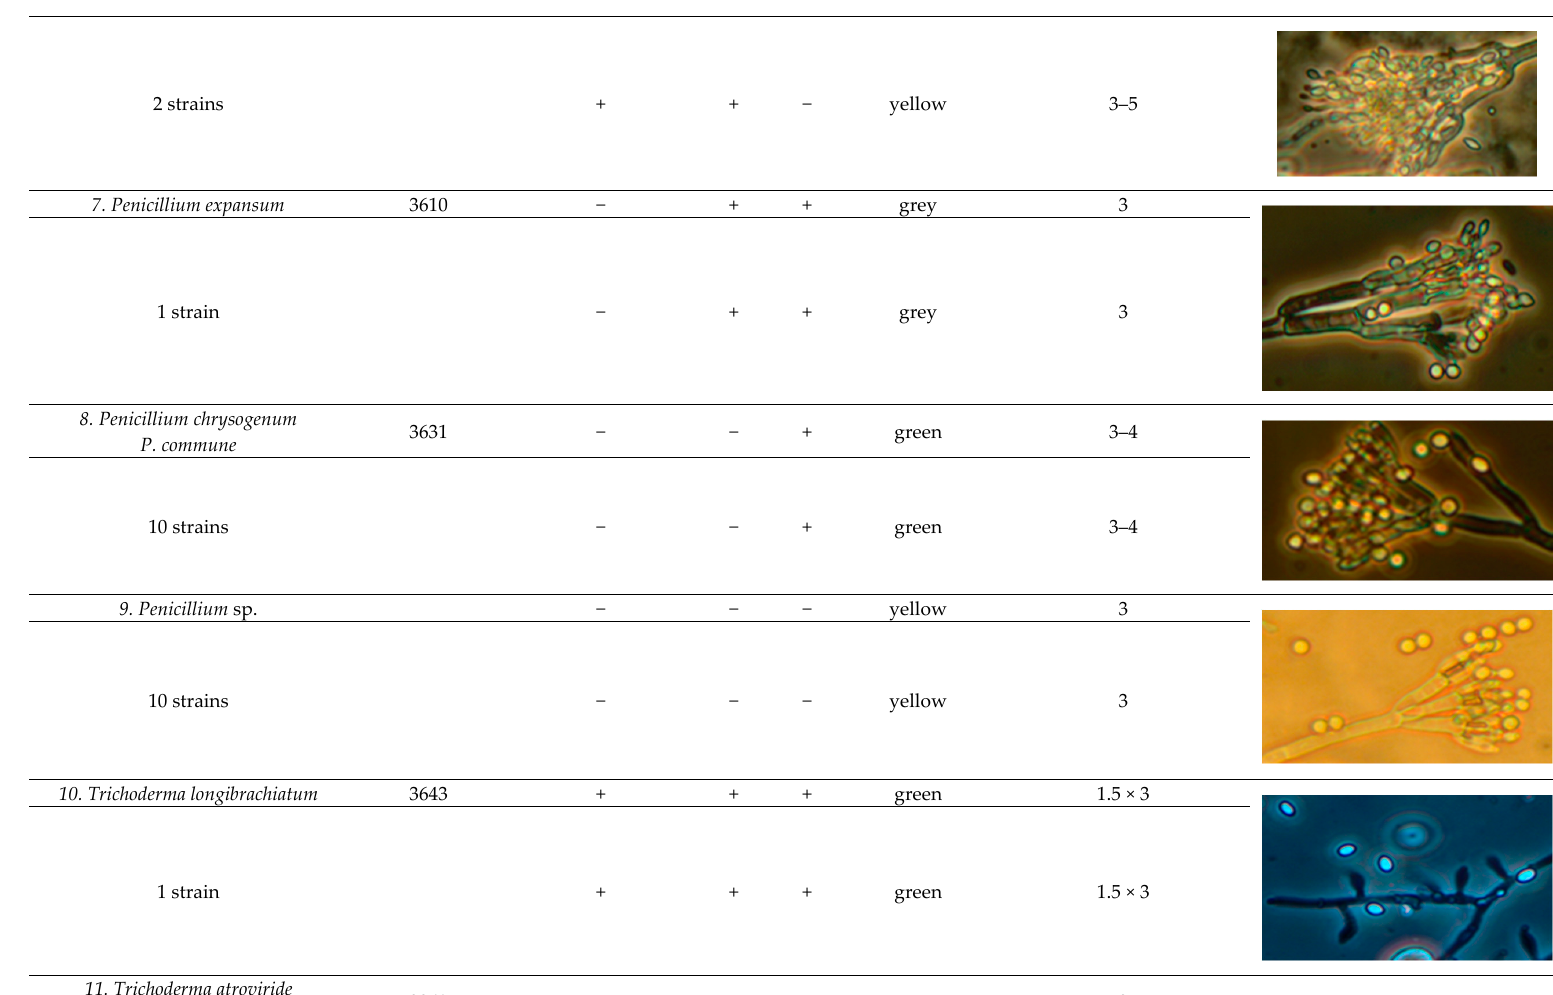
Table 7. Cont. Int. J. Environ. Res. Public Health 2018 , 15 ,